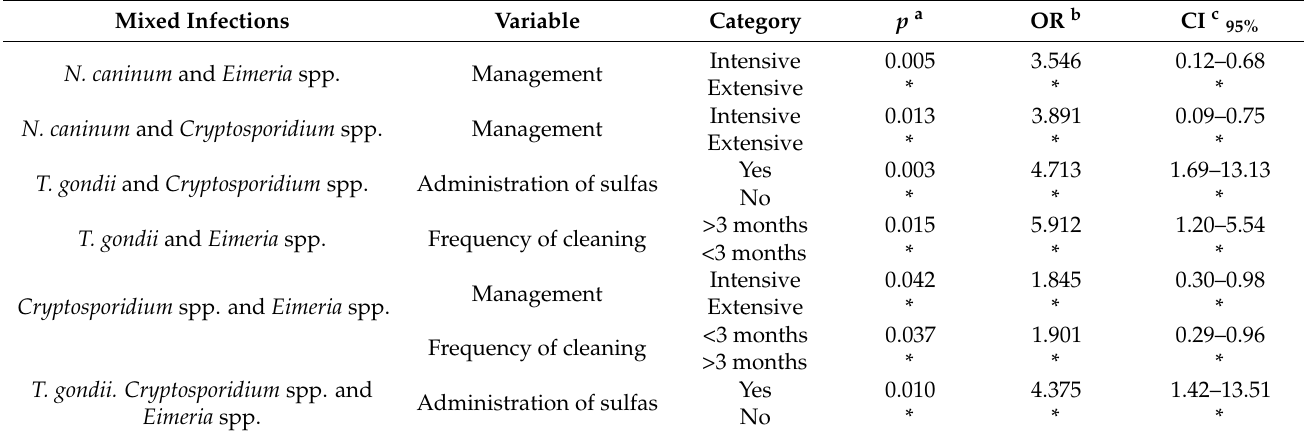
Table 5. Risk factors of mixed infections with Neospora caninum, Toxoplasma gondii, Cryptosporidium spp. and Eimeria spp. in sampled goats from Zapotillo Canton,